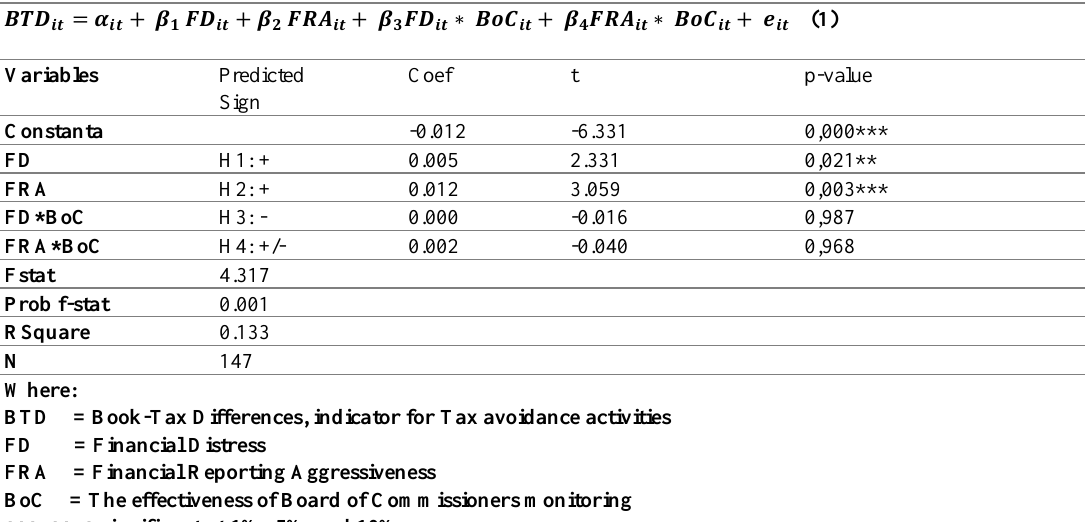
Table 3: Summary of Hypotheses Testing